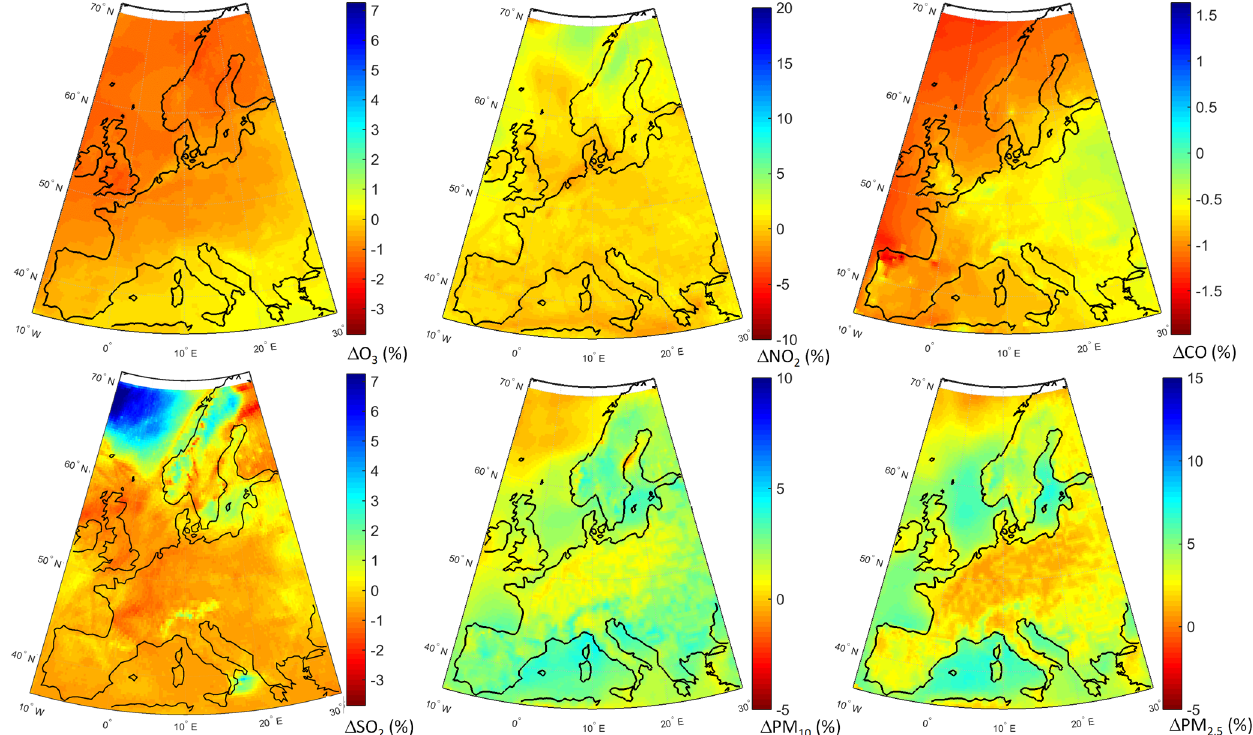
Figure 10. Spatial distribution of the annual mean relative differences between the North American emission perturbation scenario and the base case over Europe as simulated by the multi-model mean